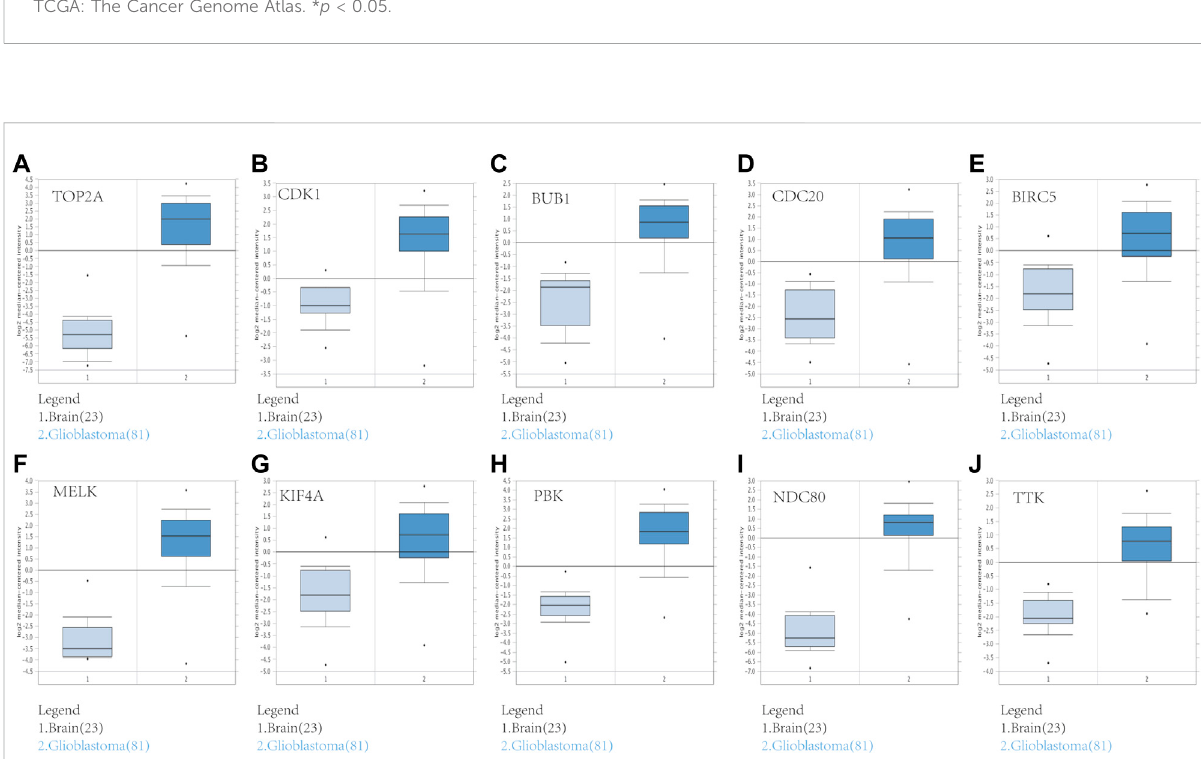
FIGURE 6 Validationofthe10hubgeneexpressionlevelsbetweennormalbrainandGBMsamplesbasedonOncominedata.Allofthe10hubgeneswere con fi rmed to be upregulated. (A) TOP2A , (B) CDK1 , (C) BUB1 , (D) CDC20 , (E) BIRC5 , (F) MELK , (G) KIF4A , (H) PBK , (I) NDC80 , and (J) TTK . * p <